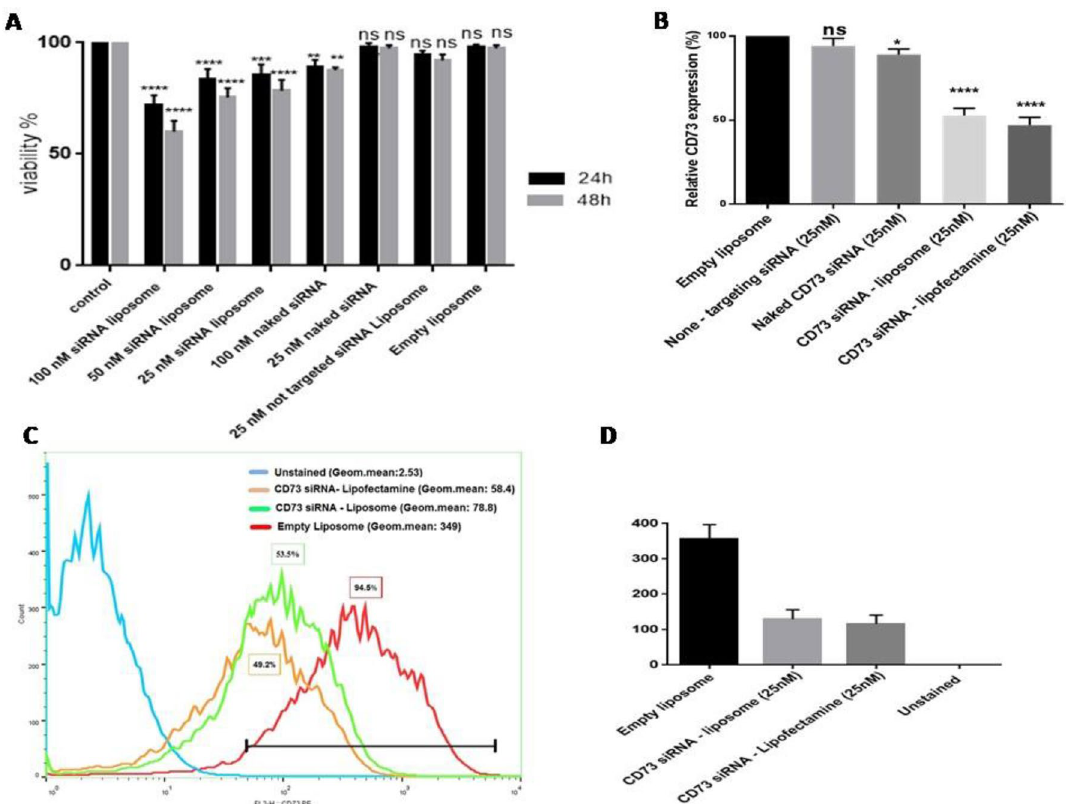
Figure 4. Evaluation of siRNA-mediated downregulation efficiency and toxicity of CD73 siRNA in 4T1 cell line. ( A ) Cytotoxicity of formulations including liposomes containing CD73 siRNA (100, 50, and 25 nM), naked CD73 siRNA (25 and 100 nM), non-targeting siRNA (25 nM), and empty liposomes was evaluated by MTT assay. The data are the mean ± SD of triplicate experiments. ( B ) After 48-h incubation of 4T1 cell with different formulations, the impact of liposomal CD73 siRNA and lipofectamine-CD73 siRNA (positive control) on the level of CD73 mRNA were assessed by real time PCR method. Both liposomes containing CD73 siRNA (25 nM) and lipofectamine CD73 siRNA complex (25 nM) can inhibit CD73 mRNA expression level up to 51%, but the naked form of CD73 siRNA and non-targeting siRNA could not affect CD73 expression effectively. ( C , D ) The results of flow cytometry analysis also demonstrated that liposomes containing CD73 siRNA and lipofectamine transfected group decrease the CD73 expression as compared with the empty liposome trol group ( P value < 0.0001). However, comparison of liposomal CD73 siRNA (Lipo CD7 siRNA) with GE11- Lipo CD73 siRNA showed that the targeted form decreased CD73 levels more efficiently ( P value < 0.01). Flow cytometry analysis of tumor‑infiltrated lymphocytes (TILs). Analysis of tumor-infiltrated lympho- cytes. Tumor-infiltrated lymphocytes (TILs) analysis showed that the frequency of TIL in the tumor environ- ment of Liposomal doxorubicin, GE11-Lipo CD73 siRNA+ Liposomal doxorubicin, GE11 liposomal siRNA, liposomal siRNA, negative control siRNA (NC siRNA), Naked CD73 siRNA, and PBS-treated groups are equal to 1.46 ± 0.12, 2.07 ± 0.32, 3.51 ± 0.38, 2.82 ± 0.62, 3.56 ± 0.51, 3.46 ± 0.76 and 4.32 ± 0.39, respectively. Treatment of mice with Doxorubicin significantly reduced the number of TIL in both groups including liposomal doxo- rubicin ( P < 0.05) and GE11-Lipo CD73 siRNA+ liposomal doxorubicin ( P < 0.01) (Fig. 8A). The results of TIL subpopulations analysis are presented in Fig. 8. Chemotherapy with doxorubicin negatively and significantly decreased the frequency of CD4 + and CD8 + T lymphocytes in mice treated with liposomal doxorubicin and combination therapy (GE11-Lipo CD73 siRNA+ liposomal doxorubicin) groups. Meanwhile, GE11-Lipo CD73 siRNA in combination with liposomal doxorubicin could also attenuate the cytotoxic effects of Doxorubicin. Figure 8B,C clearly show that while liposomal doxorubicin significantly decreased the frequency of CD8 + , treat- ment with GE11-Lipo CD73 siRNA could not decrease the frequency of CD8 + T cells at tumor site. The result of Fig. 8D showed that the frequency of CD8 + IFN + in the liposomal doxorubicin group has significant differences from the control group ( P < 0.05). On the other hand, the analysis of CD4 + INF + in CD3 gated cells showed that there is not any significant difference between the liposomal doxorubicin group and the control group. However, the comparison of liposomal doxorubicin with GE-Lipo CD73 siRNA showed significant differences (Fig. 8E). Moreover, treatment of mice with GE11-Lipo CD73 siRNA alone and in combination with liposomal doxoru- bicin could significantly decrease the frequency of CD25 + FoxP3 + Treg cells compared to control group. Interest-